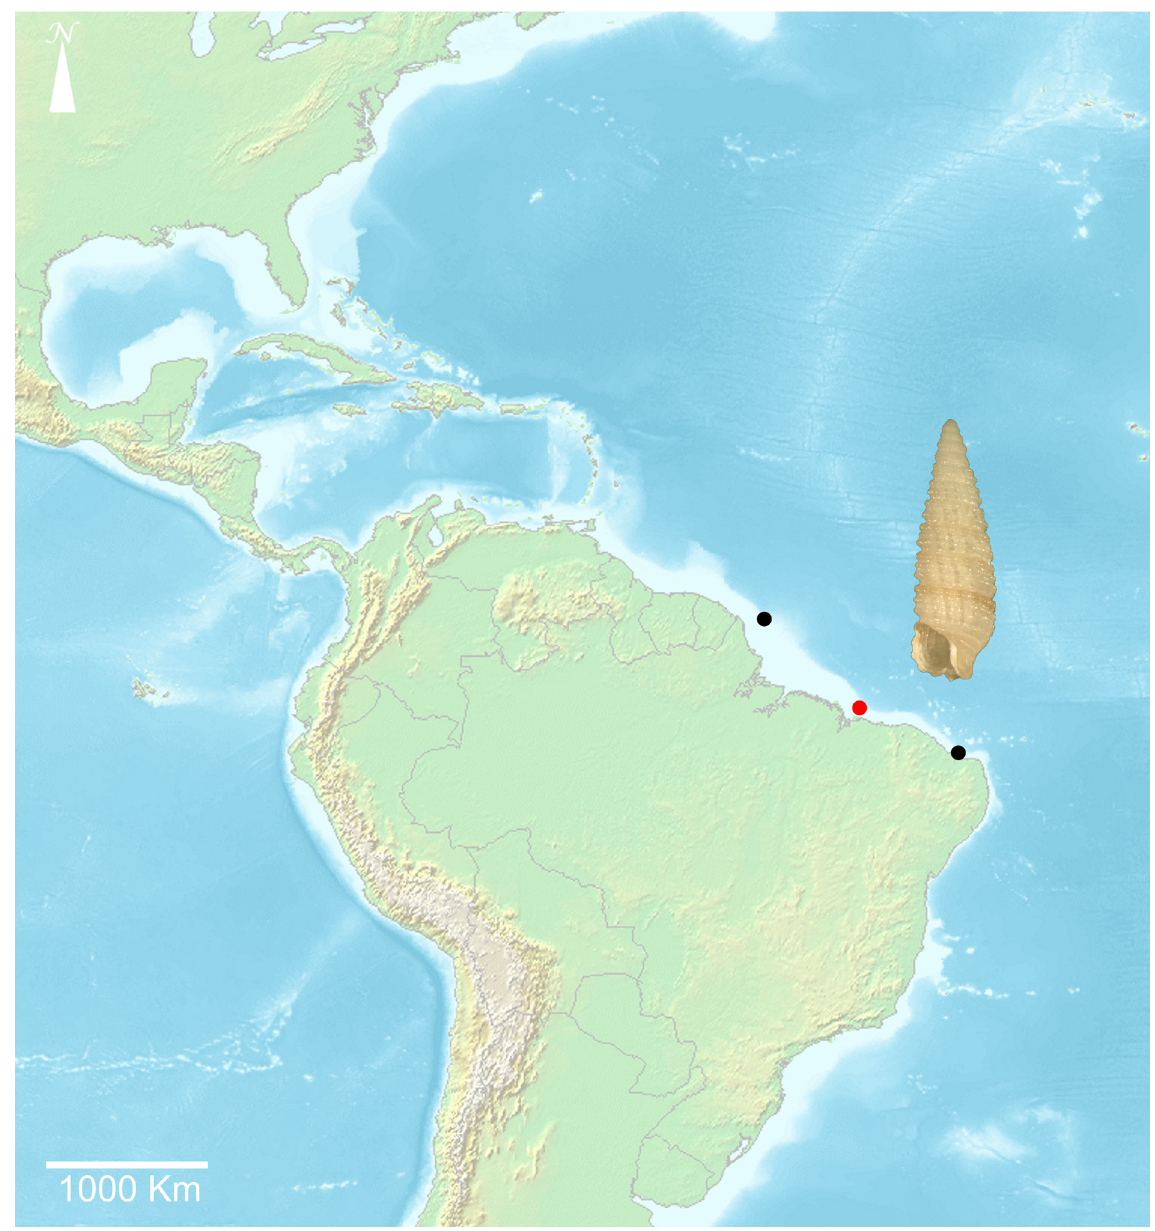
Fig. 66. Distribution map of Similiphora lucida sp. nov.; red circle = type